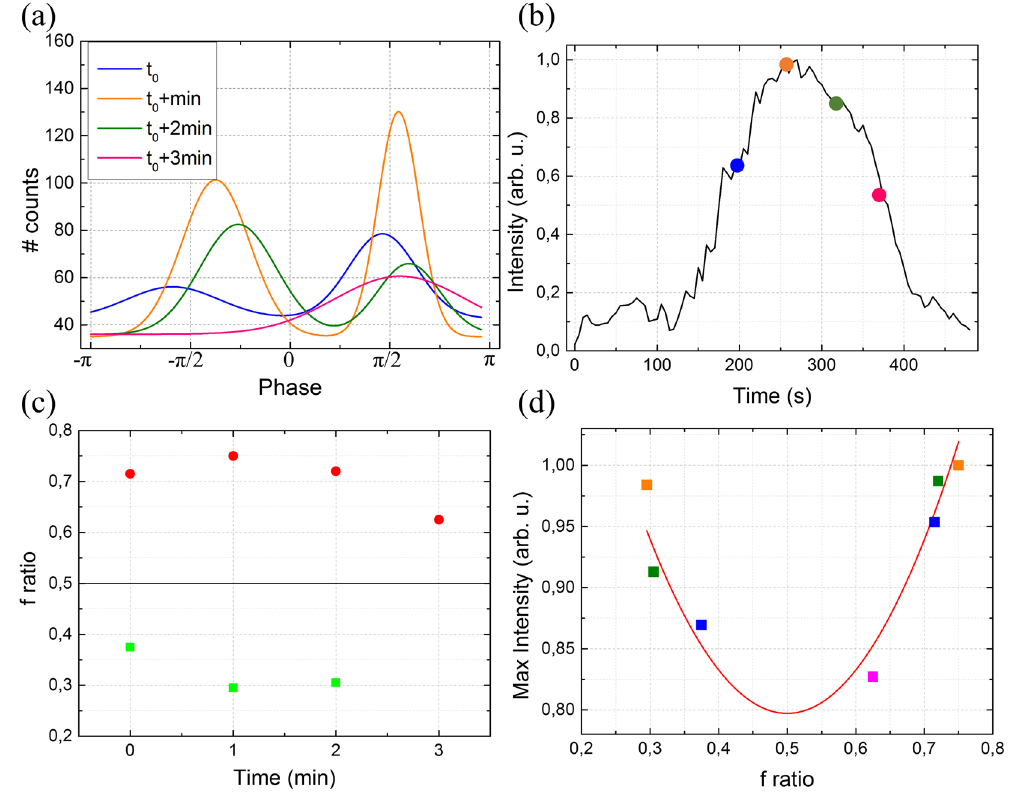
Figure 4. ( a ) Phase histogram at different time points highlighting the narrowing of the peak after 1 and 2 min. ( b ) Average intensity in the field of view (from Fig. 1) versus time. Colored circles correspond approximately to the time points in a. ( c ) Evolution of the f ratio with time. There is only one point at 3 min since only one peak (centered at π /2) is observable in the phase histogram at this time, due to quasi-random MTs polarity at this time. ( d ) Correlation between the maximum SHG intensity and the f ratio. The colored squared display the data extracted from ( a ) and the red line is the theoretical dependency (Eq.